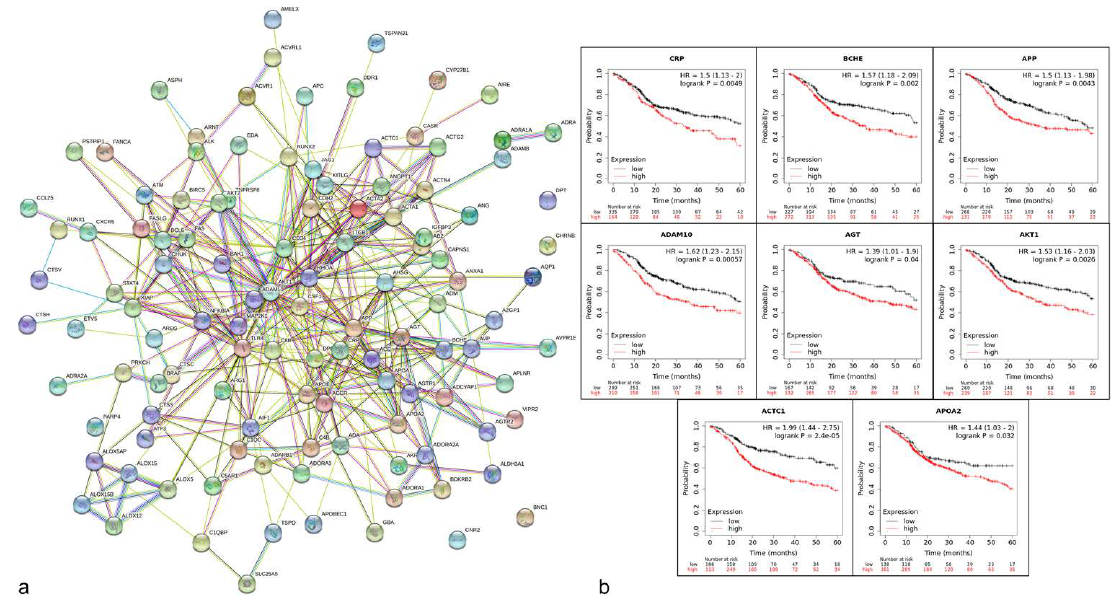
Figure 3. Bioinformatic analysis. ( a ) Network construction of protein-protein interactions. Number of nodes: 116; number of edges: 414; average node degree: 7.14; avg. local clustering coefficient: 0.507; expected number of edges: 157; and PPI enrichment p -Value: 1.0 × 10 -16 , ( b ) Kaplan–Meier plots of survival relationship with hub genes obtained, these genes showed an HR >1 and p < 0.05.